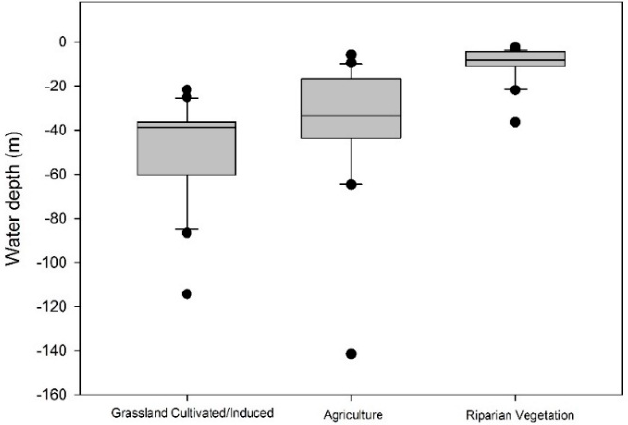
Figure 4. Land cover relationship to average water depth in the ZR and SMR sub-watersheds.